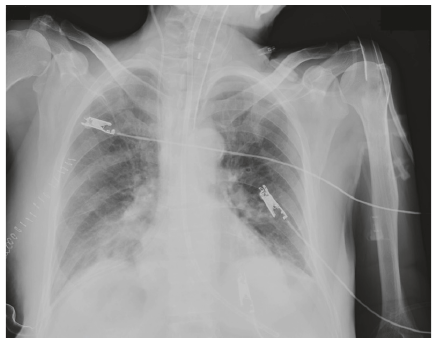
Figure 5: Complete expansion of the lung after the thorax tube was